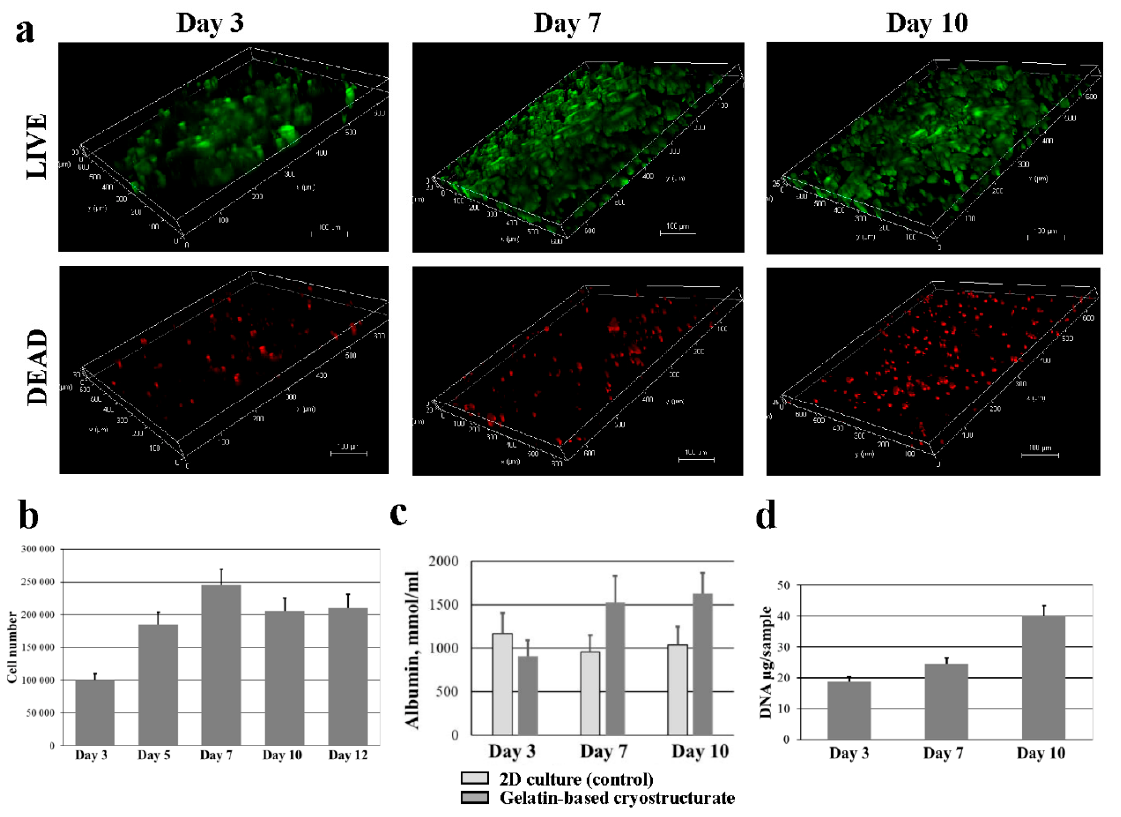
Figure 5. Proliferation and liver function of HepG2 cells attached to gelatin ‐ based cryostructurate. ( a ) HepG2 viability at 3, 7, 10 days on gelatin gelatin ‐ based cryostructurate. Live cells were ( a ) HepG2 viability at 3, 7, 10 days on gelatin gelatin-based cryostructurate. Live cells were green- green ‐ stained using calcein ‐ AM, and dead cells were red ‐ stained using ethidium homodimer. Scale stained using calcein-AM, and dead cells were red-stained using ethidium homodimer. Scale bar bar 100 μ m; ( b ) HepG2 proliferation on gelatin gelatin ‐ based cryostructurate (scale bar 100 μ m); ( c ) 100 µ m; ( b ) HepG2 proliferation on gelatin gelatin-based cryostructurate (scale bar 100 µ m); ( c ) Albu- Albumin secretion; ( d ) DNA content. min secretion; ( d ) DNA